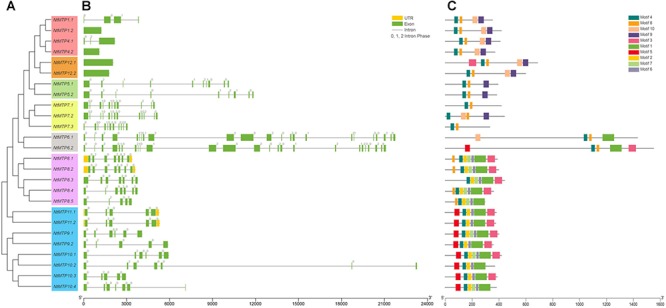
Phylogenetic relationships, gene structure and conserved motifs in MTP genes from N. tabacum. (A) Phylogenetic tree was constructed using the MEGA 6.0 software based on the full-length sequences of tobacco MTP proteins. Seven primary groups are shown in different colors. (B) Exon-intron structure of tobacco MTP genes. Yellow boxes indicated untranslated 5′- and 3′-regions; green boxes indicate exons; black lines indicate introns. The number indicates the phases of corresponding introns. (C) Conserved motifs were identified by MEME and displayed in different colored boxes.